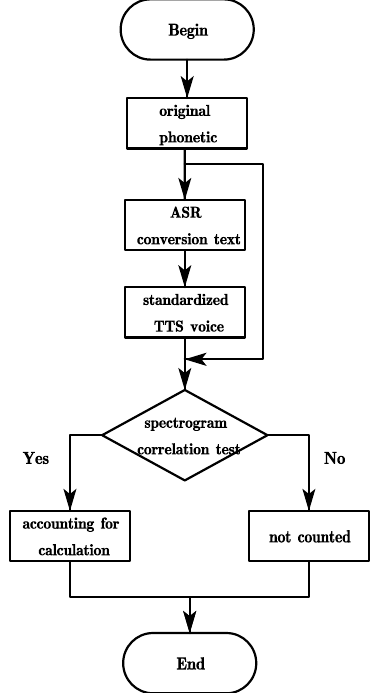
Figure 4. Schematic diagram of TTS matching mechanism.